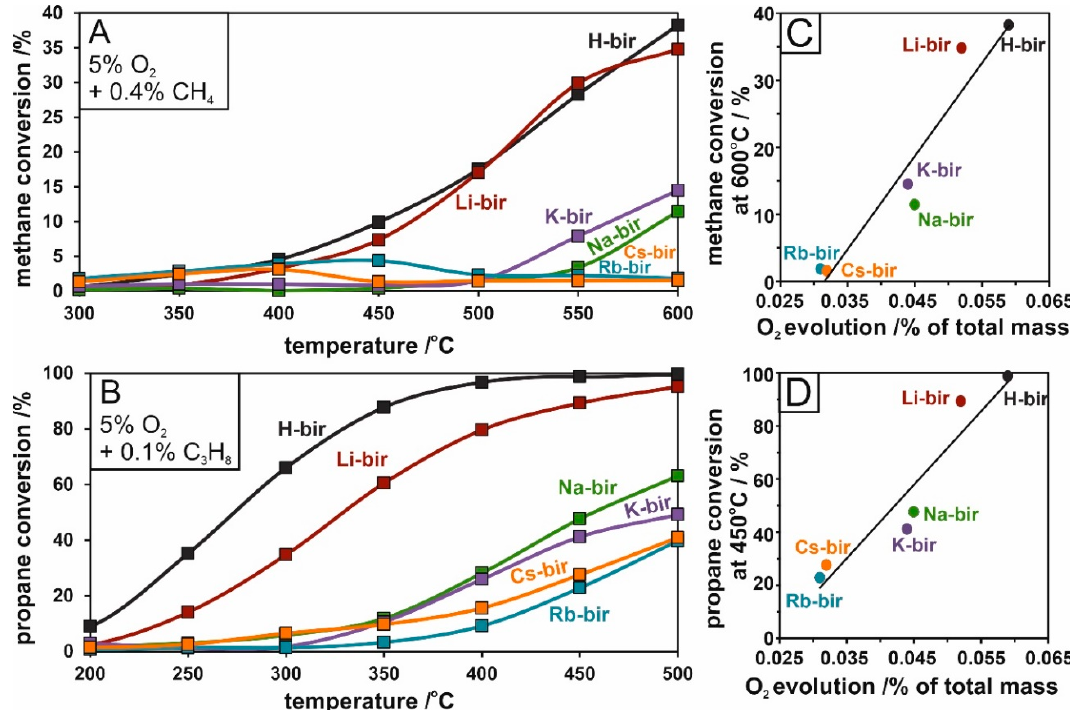
Figure 10. Methane ( A ) and propane ( B ) conversion plots for bulk alkali-promoted birnessite and the resulting correlations of total O 2 evolution and hydrocarbon conversion for methane at 600 ◦ C ( C ) and propane at 450 ◦ C ( D ).